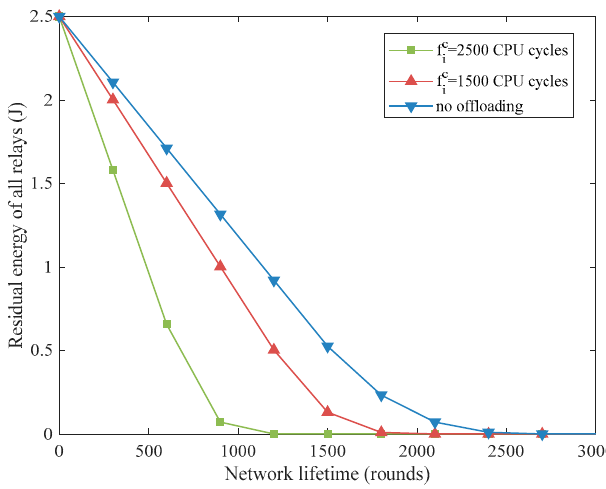
Figure 4. Residual energy of all relays versus time under different scenarios.